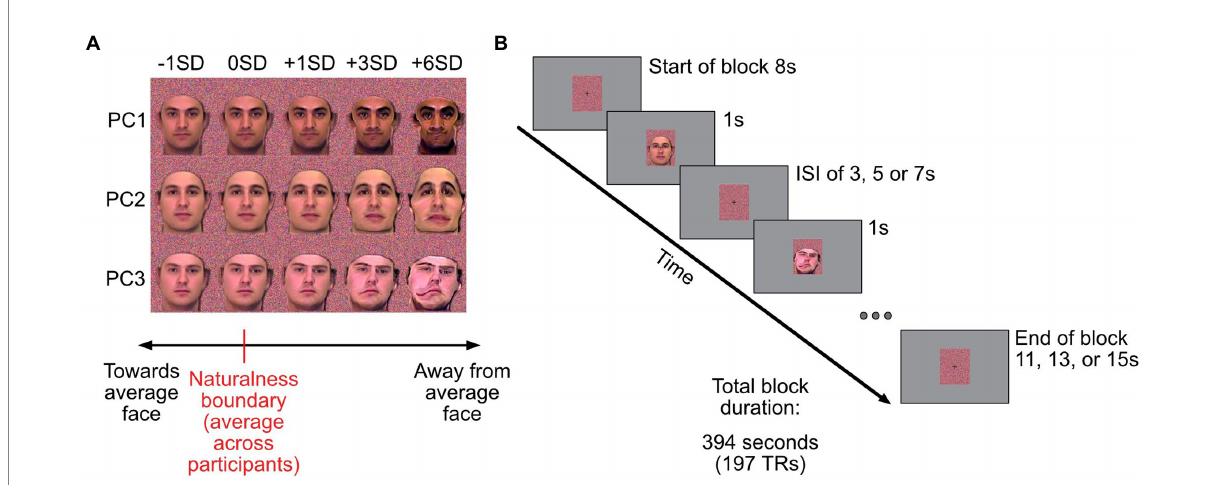
FIGURE 2 Caricatured stimuli used and outline of the fMRI experiment. (A) Example images corresponding to the five scaling levels used in the MRI experiment. First column of images: stimuli that are 1 standard deviation (SD) closer to the average face. Second column: group-averaged naturalness boundary for a given component (0SD). Other columns: images corresponding to +1, + 3 and + 6SD away from average. Stimuli were presented on colour masks (Gaussian noise on each R, G, B channel, with mean and standard deviation derived from the face stimuli). (B) Timings for trials in the event-related caricature scan. The experiment started and ended with 8 s of fixation (dynamically changing coloured masks only). Stimuli were presented for 1 s, followed by a variable inter-stimulus interval of 3, 5 or 7 s. To control for attention, participants had to report colour changes of the fixation cross (black to red), which occurred randomly 42 times within each run. The background colour mask changed dynamically every